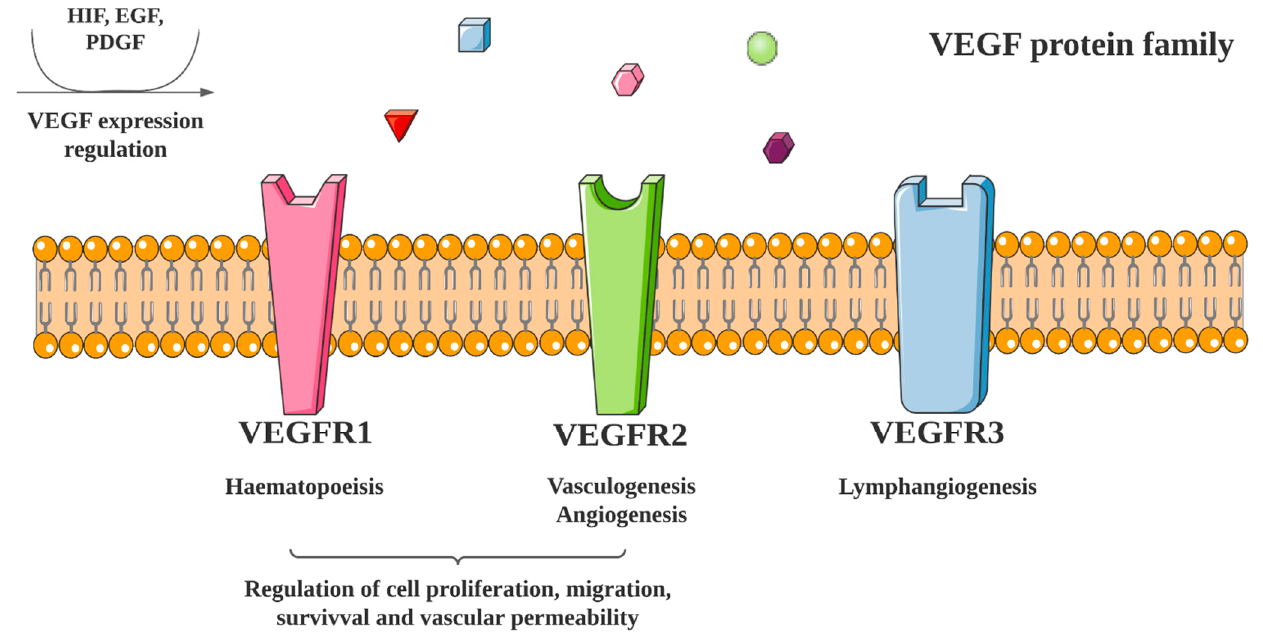
Figure 1. VEGF activation and signaling pathway. The VEGF protein family includes VEGF-A, -B, - C, -D, and -E. VEGF-A binds to VEGFR1 homo-, VEGFR2 homo- and VEGFR1/R2 hetero-dimers, VEGF-B binds to VEGFR1 homodimers, VEGF-C and -D bind to VEGFR3 homodimers and VEGF- E binds to VEGFR2